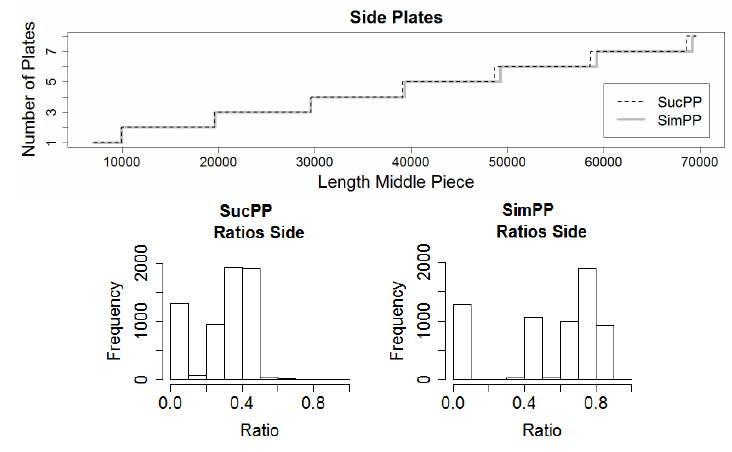
Figure 9. Comparison of the two approaches for calculating the side plate partitioning.